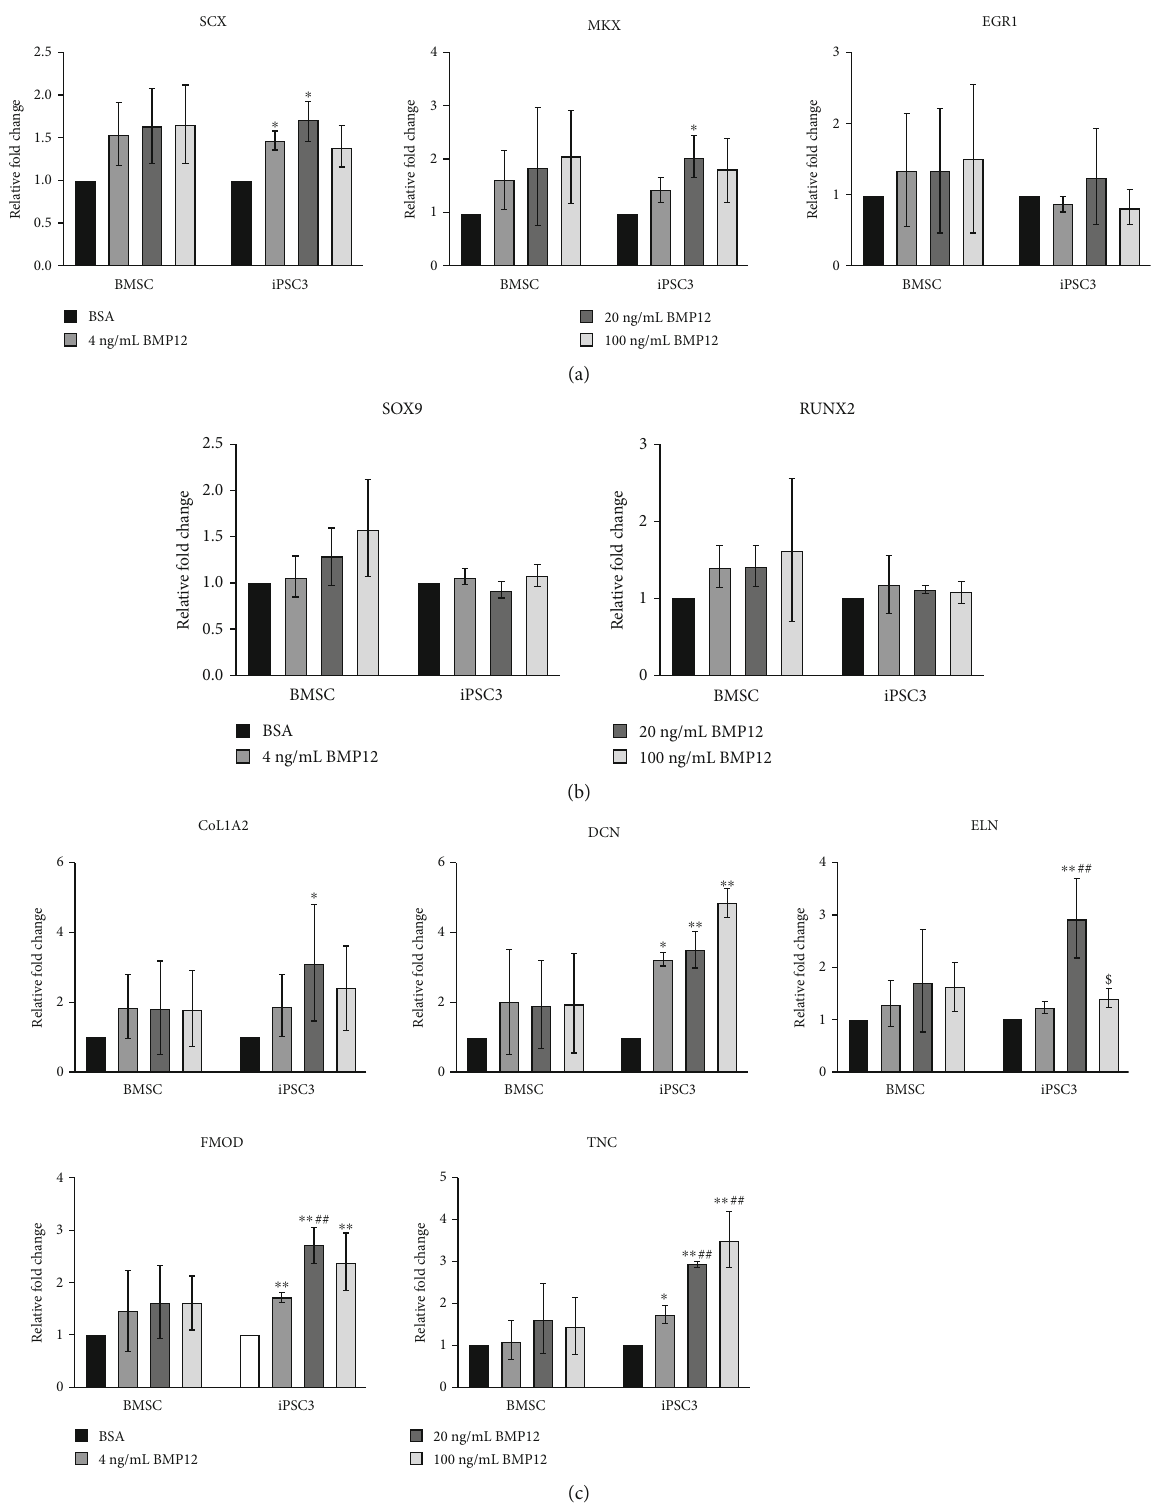
Figure 2: Dose e ff ects of BMP12 on tenogenic gene expression in BMSCs and teno-iPSCs. Cells were treated with vehicle medium (0) or various concentrations of BMP12 (4, 20, and 100ng/mL) for 5 days, and cDNA was synthesized from total RNA. Expression of tenogenic transcription factors (a), SOX9 and RUNX2 (b), and tenocyte-related ECM genes (c) was determined by qPCR. Relative fold change for each group was calculated by comparison to vehicle medium group. ∗ Data were compared to BSA control; # data were compared to the 4ng/mL group; $ data were compared to the 20 ng/mL